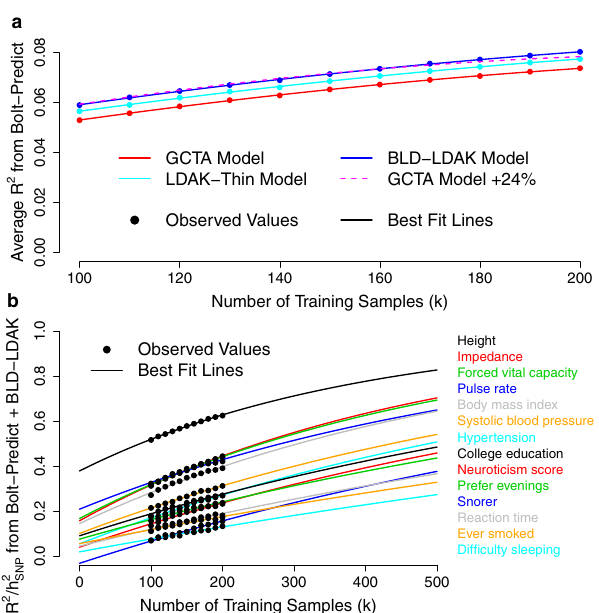
Fig. 3 Dependency of prediction accuracy on sample size. a We use LDAK-Bolt-Predict to construct PRS for the fi rst 14 phenotypes, varying n , the number of training samples, between 100,000 and 200,000. We measure the accuracy of each PRS via R 2 , the squared correlation between observed and predicted phenotypes across 20,000 test samples. Points report R 2 averaged across the 14 phenotypes; colors indicate the assumed